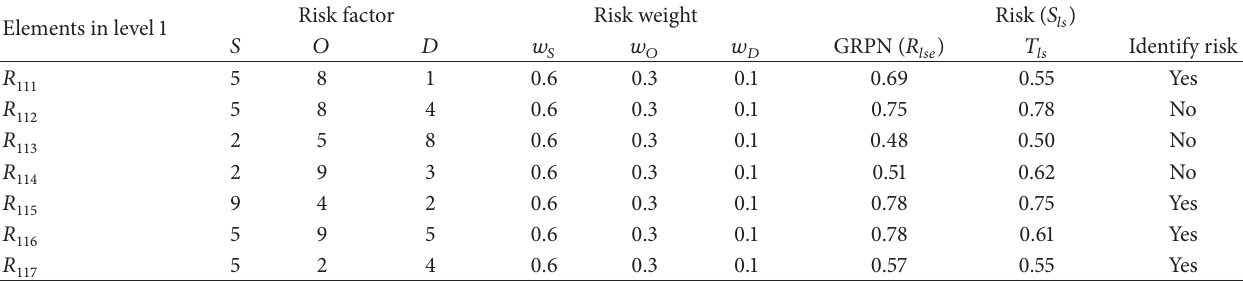
Table 14: Adaptive risk identification with scenario of risk weight threshold: homo-hetero. Elements in level 1